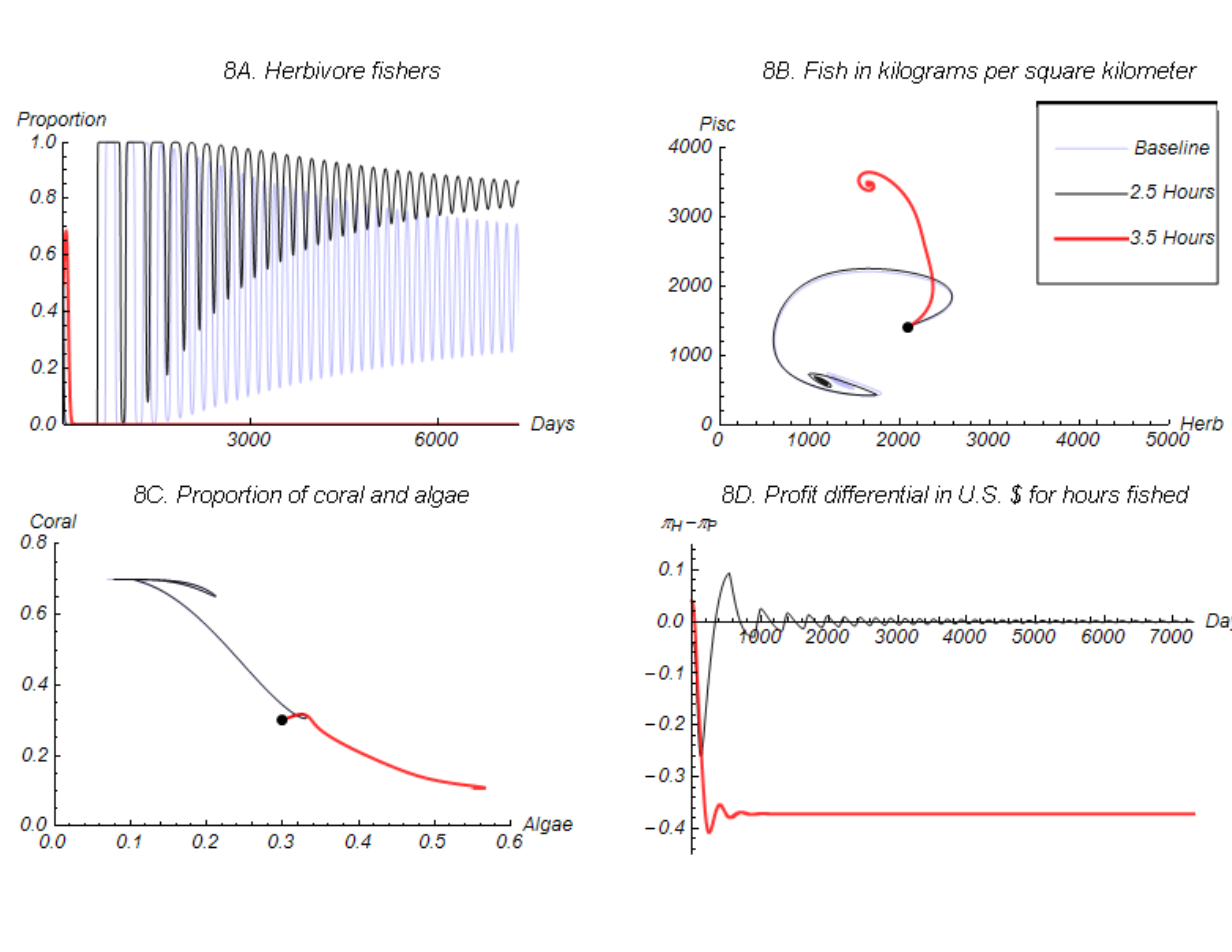
Fig. 8 . Simulation results reflecting changes in fisher effort (h/d) for herbivorous fish, showing time- series plots for fishers (8A) and profit differentials (8D), and parametric plots for fish (8B) and for coral and algae (8C). The dots represent initial